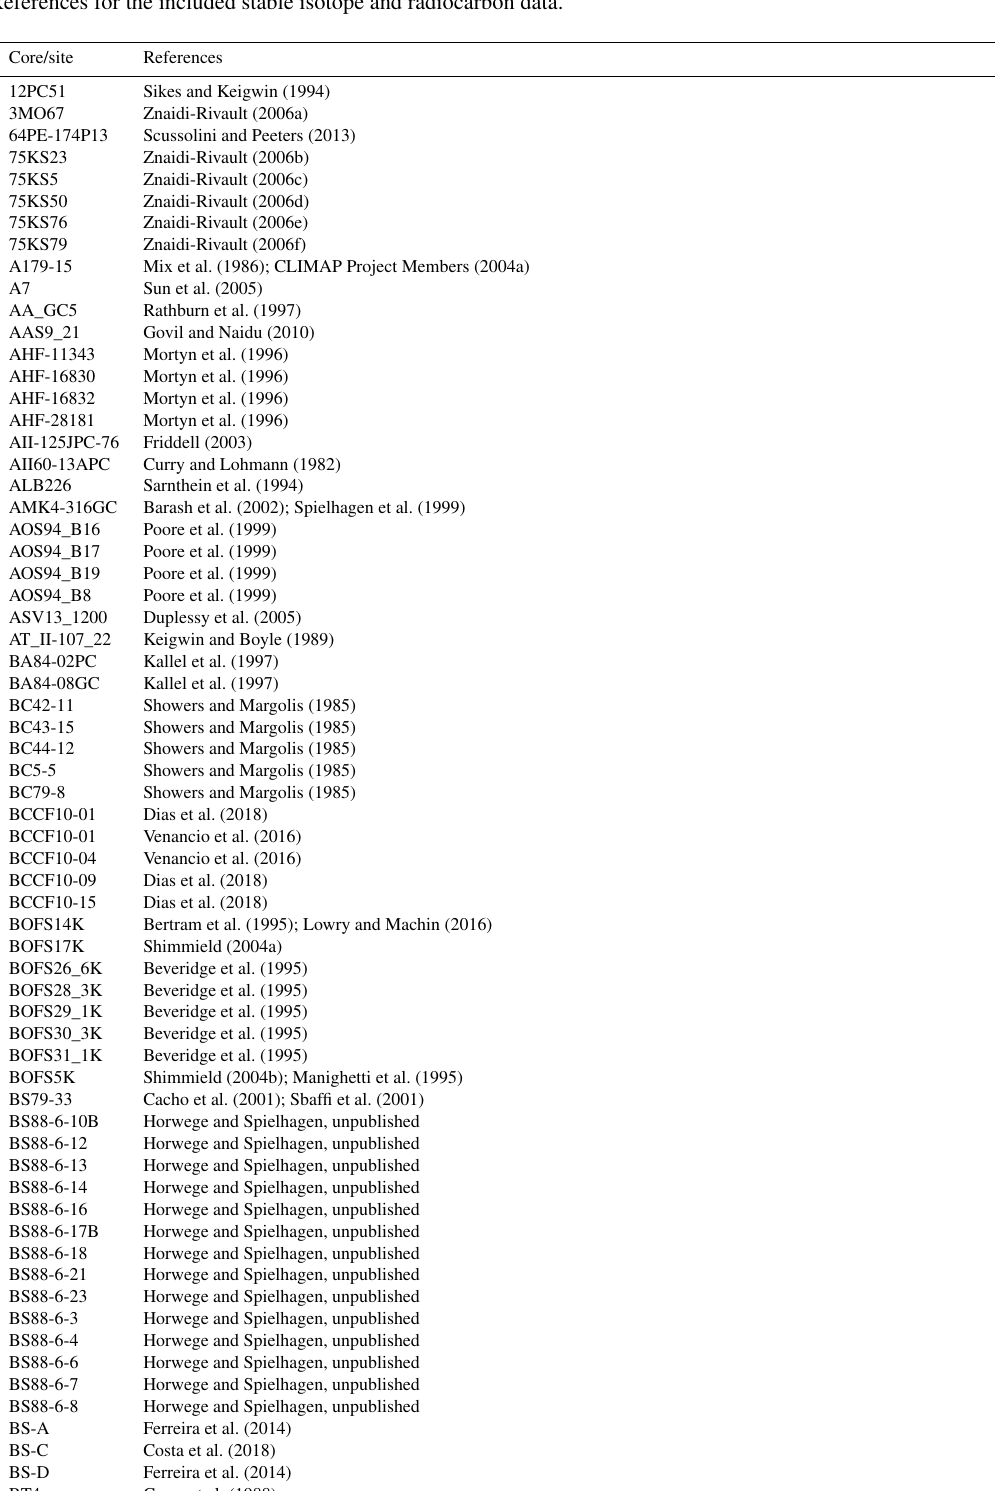
Table A1. References for the included stable isotope and radiocarbon